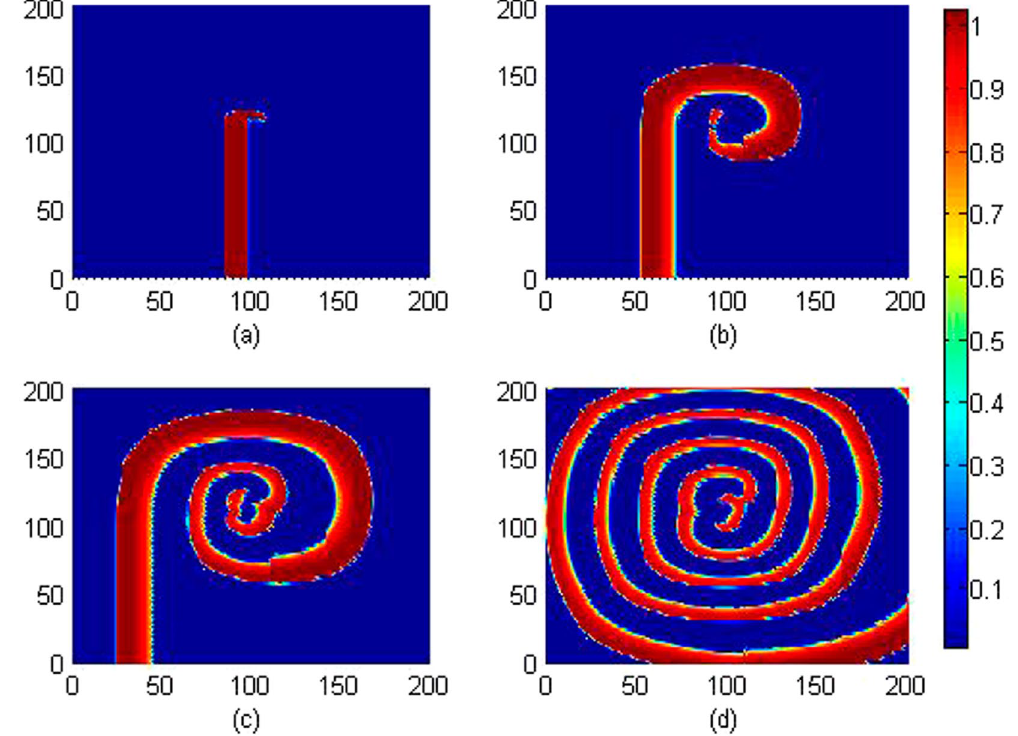
Figure 3. Developed spatial pattern is plotted for the media at t = 10, 60, 100, 200 time units under feedback gain k 0 = 0.1, respectively. The snapshots are shown color scale.